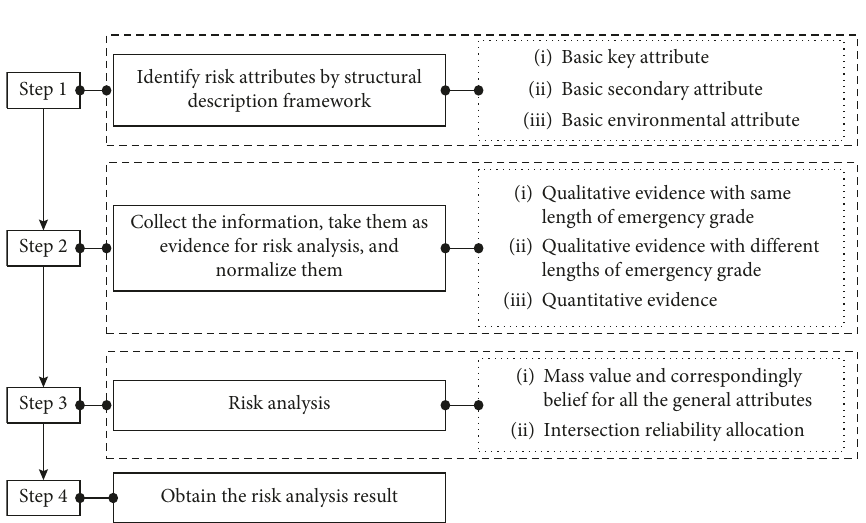
Figure 3: Framework of fuzzy evidential reasoning